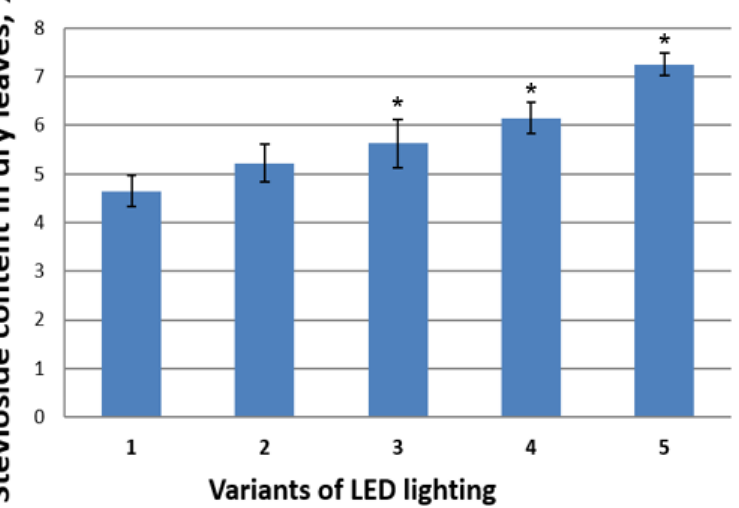
Figure 10. The effect of spectral light composition on stevioside content in S. rebaudiana plants grown in vivo under different treatments of red-blue LED lighting: (1) SR + LR + FR + B; (2) LR + FR + B; (3) SR + FR + B; (4) SR + LR + B; and (5) SR + LR + FR (Figure 2). Means ± standard errors at α = 0.05 according to ANOVA tests ( n = 10). *-variants that have significant differences between control treatments (SR + LR + FR + B).